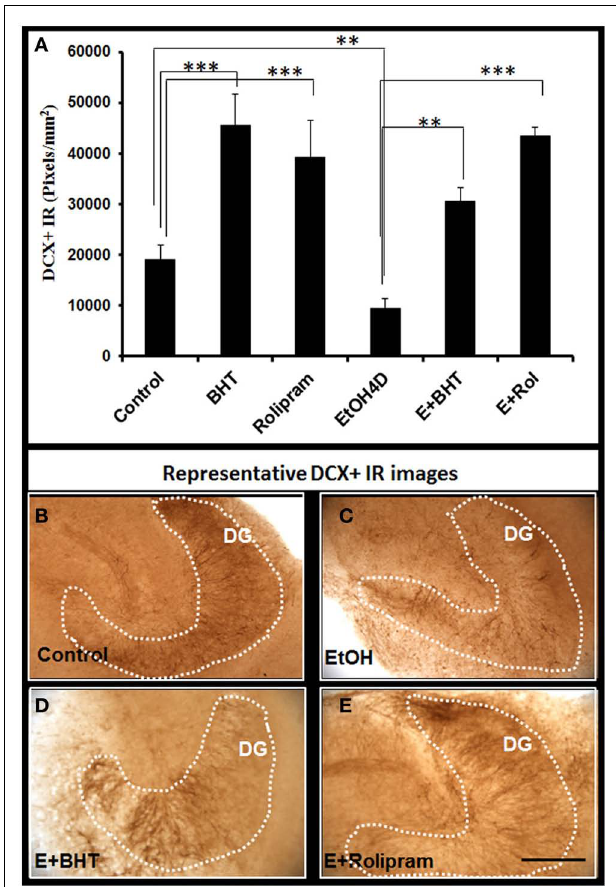
FIGURE 9 | Rolipram and anti-oxidant BHT protect from ethanol-impaired neurogenesis. Shown in bar graph (A) : PDE IV inhibitor rolipram and anti-oxidant BHT increase DCR + IR and reverse ethanol inhibition of DCX + IR. ANOVA F (5, 32) = 11.552, p < 0.001, and Fisher post hoc : *** p < 0.001 or ** p < 0.01 compared with Control or EtOH4D, n = 6–8.The experiments were repeated with similar results. Representative photographs of DCX + IR are shown in (B) (control); (C) (EtOH); (D) (Ethanol + BHT, 50mM, pretreatment for 3days); and (E) (Ethanol + Rolipram, 500nM, pretreatment for 3days; scale bar = 200 μ